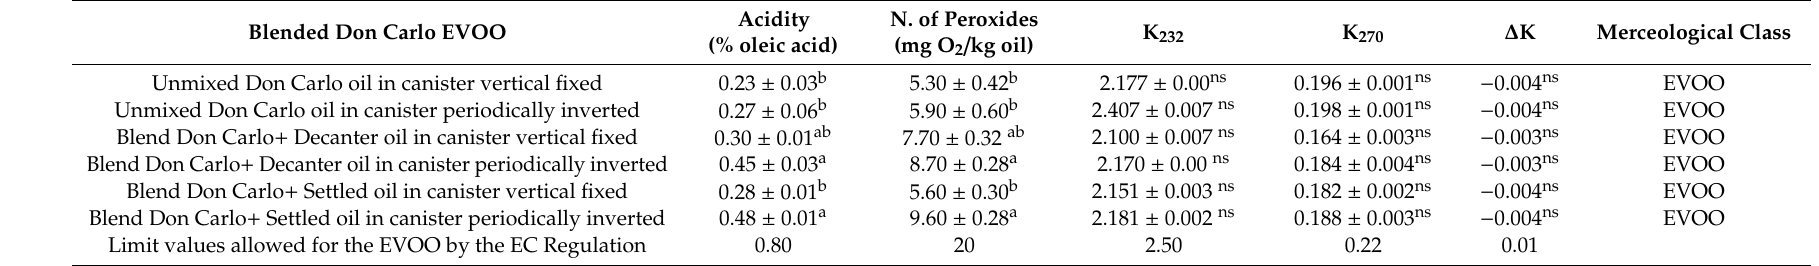
Table 6. Chemical analyses of unmixed and blended Don Carlo EVOO after three months of